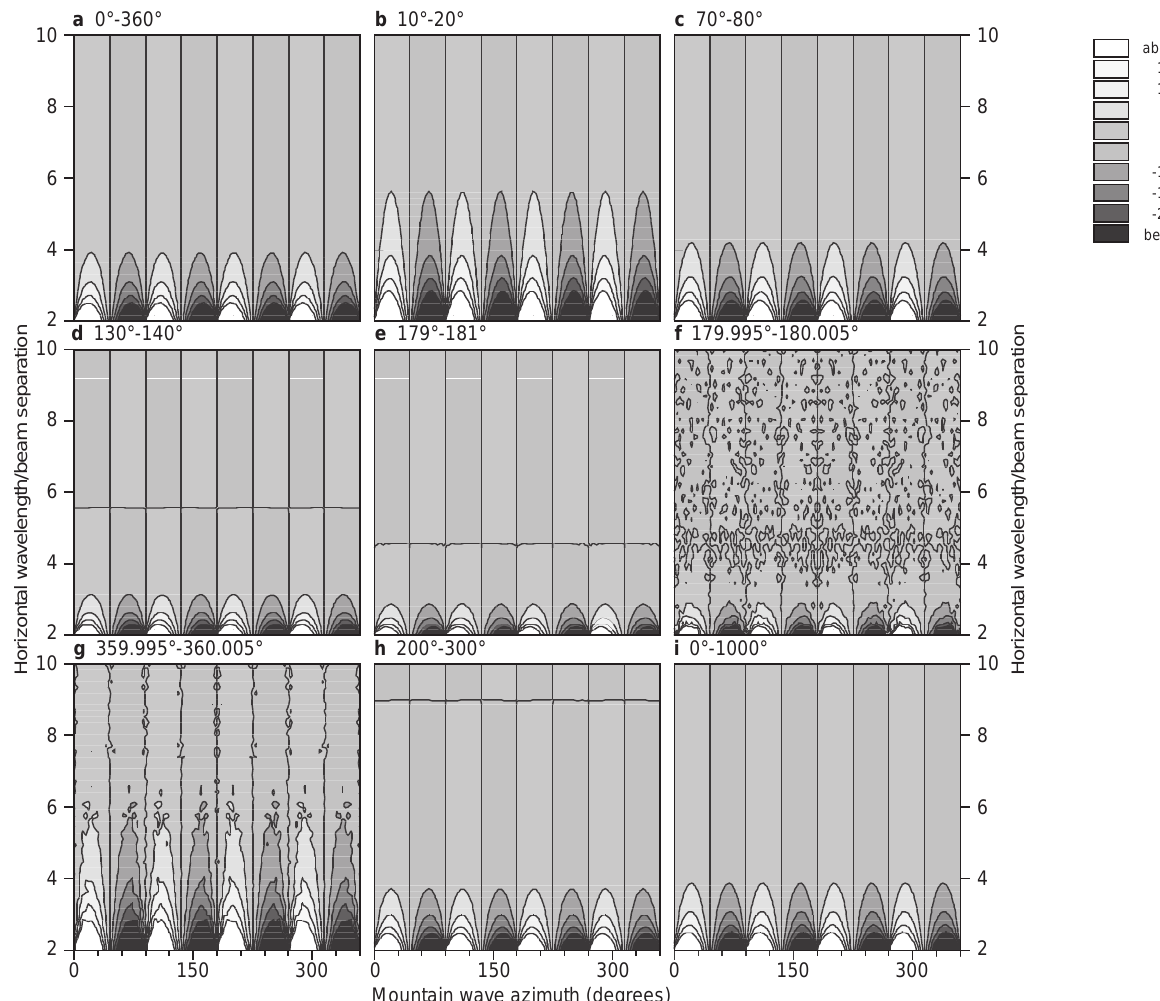
Fig. 11. Error in the calculated mountain-wave azimuth caused by the tilted radar-scattering layers being curved not plane, for various ranges of wave phase. When the horizontal wavelength is much greater than the radar beam separation, the layers can be assumed